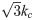
Spatially uncorrelated position disorder in hexagonal RGC mosaics induce broadband noise in iso-orientation domain layouts.
A Numerically calculated orientation domain layouts with disorder strength η = 0.12. From left to right: Moiré interference pattern, filtered Moiré interference pattern (OSI > 0.25), smooth layout and the smoothed layout’s amplitude spectrum. Insets show magnified regions. Circles in the amplitude spectrum mark k
c (red) and 3kc (blue) (cf. Eq (6)). B As A but for a higher disorder strength η = 0.30. C Radially averaged normalized amplitude spectra of the orientation domain layouts for different disorder strengths. The fluctuation strength is color coded (legend). x-axis is given in units of k
c (cf. Eq (6)). D As C but for the smoothed layouts. All other model parameters as in Fig 3.